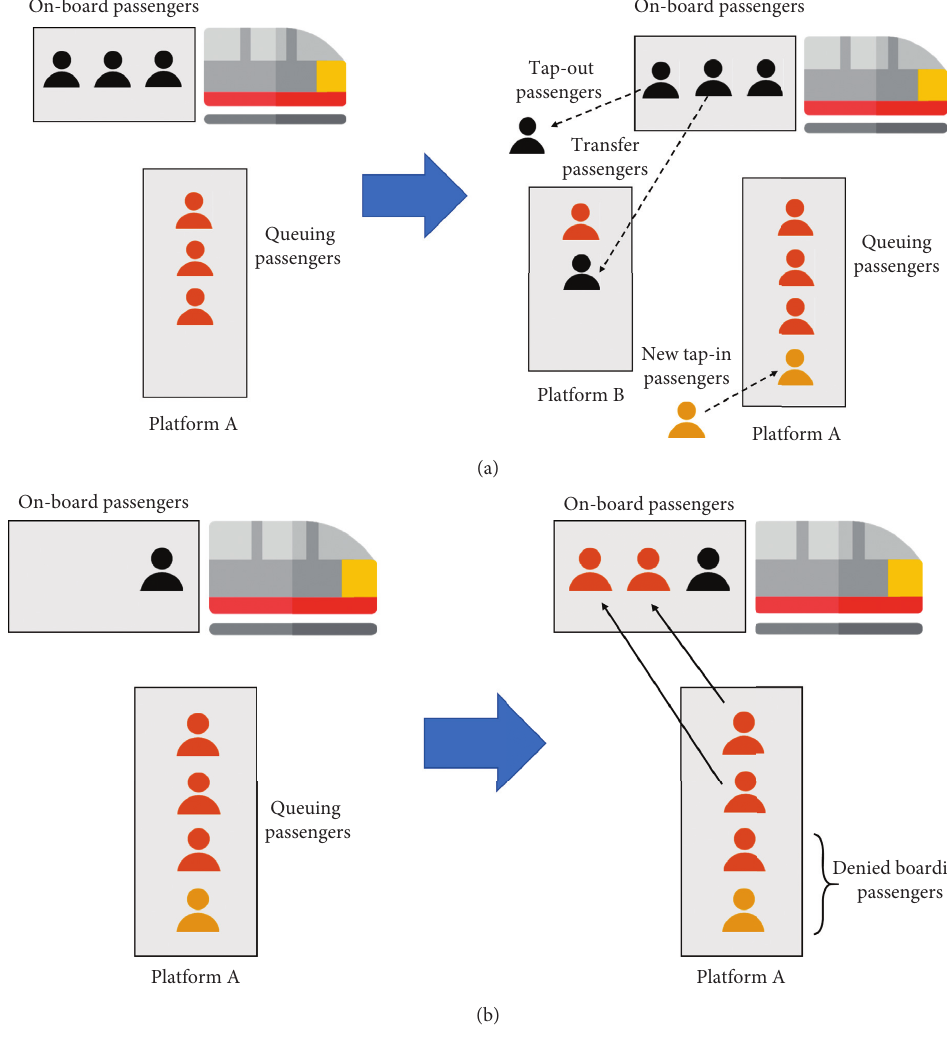
Figure 2: Main functions of the event-based transit network loading model. (a) Train arrival. (b) Train